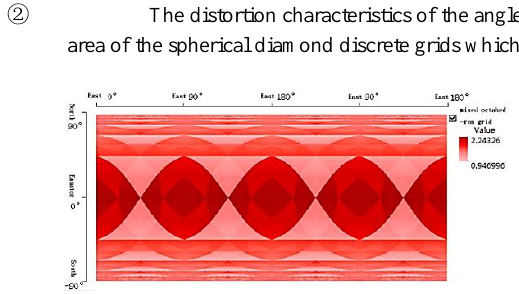
Figure 6. The planar distribution of octahedron grid divided by